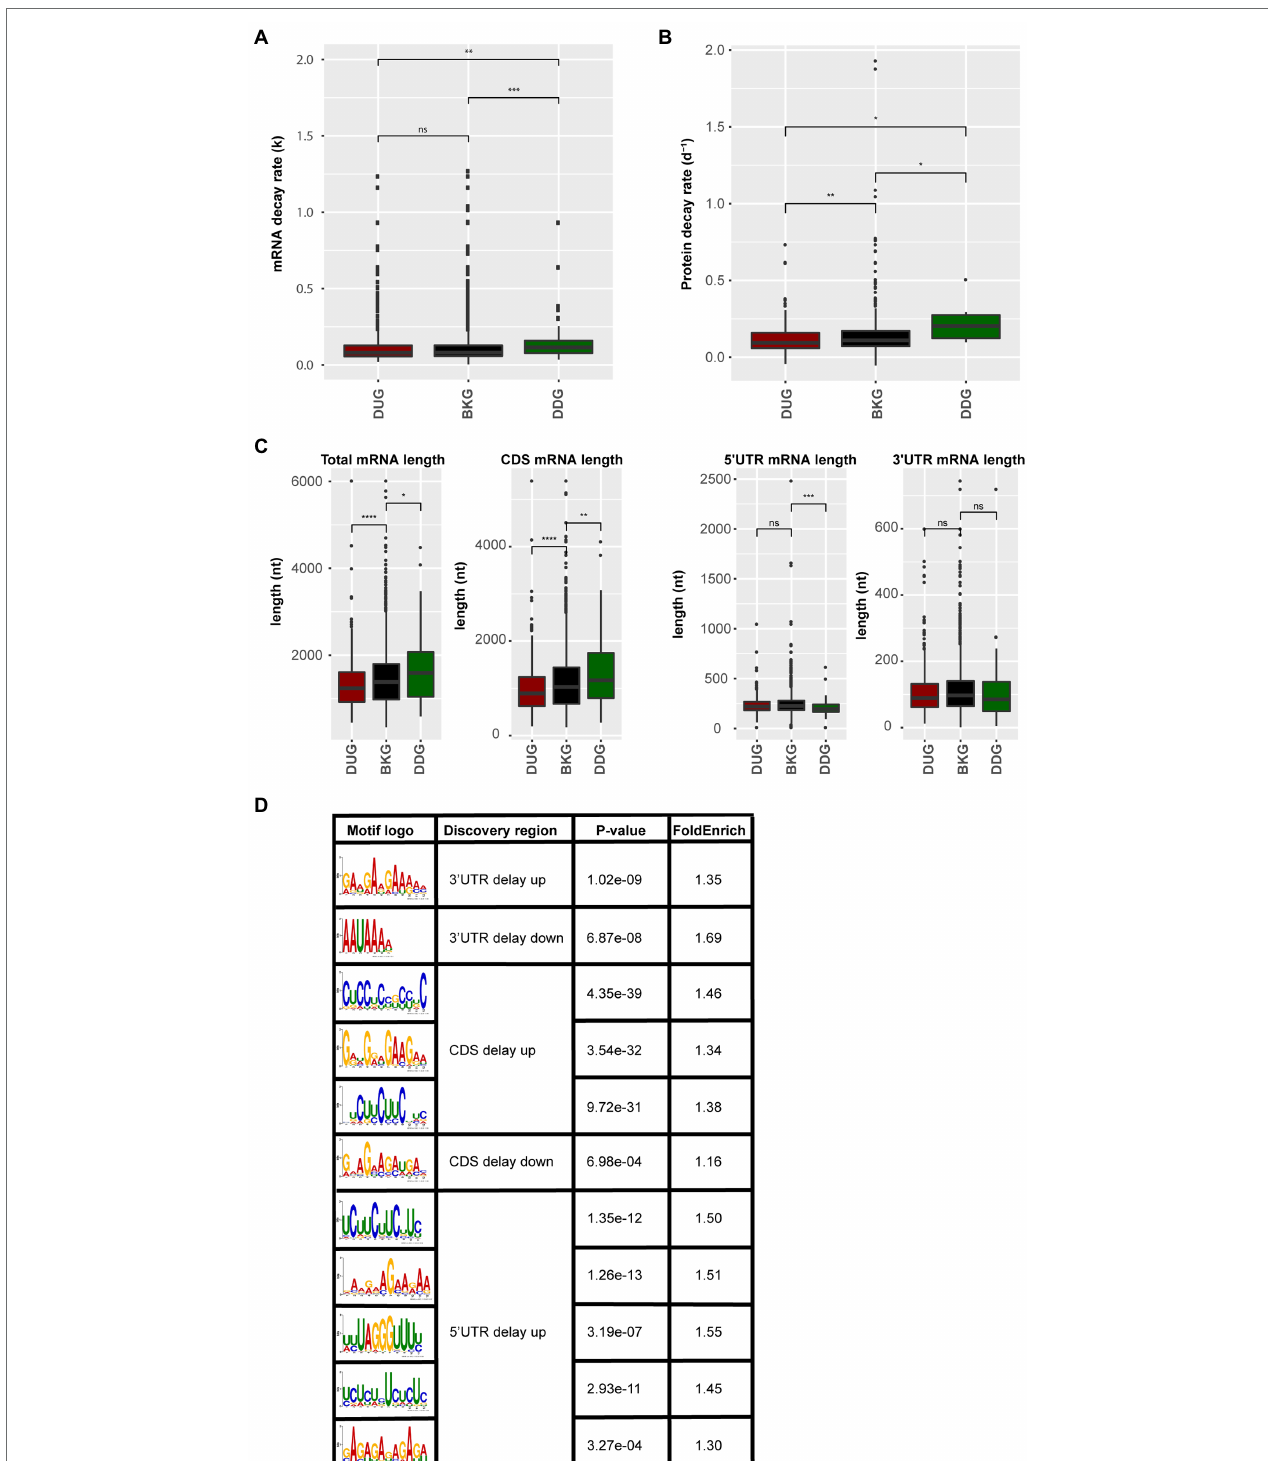
FIGURE 4 | mRNA and protein sequence features for the protein delayed genes. (A) mRNA decay rate of the proteins that are delayed in abundance. (B) Protein decay rate for the delayed response genes. (C) mRNA sequence length including total mRNA length, length of coding sequence, 5 ' UTR, and 3 ' UTR for the delayed response genes (ns; p > 0.05; * p < 0.05; ** p < 0.01; *** p < 0.001; **** p < 0.0001; Wilcoxon rank-sum test). (D) Sequence motifs identified in the delayed response genes. Motif logo, the discovered sequence region (5 ' UTR, 3 ' UTR, and CDS), the p -value (Fisher test), and the fold enrichment compared to the background set (total identified protein coding genes) are shown for motifs identified in the DUG and the DDG